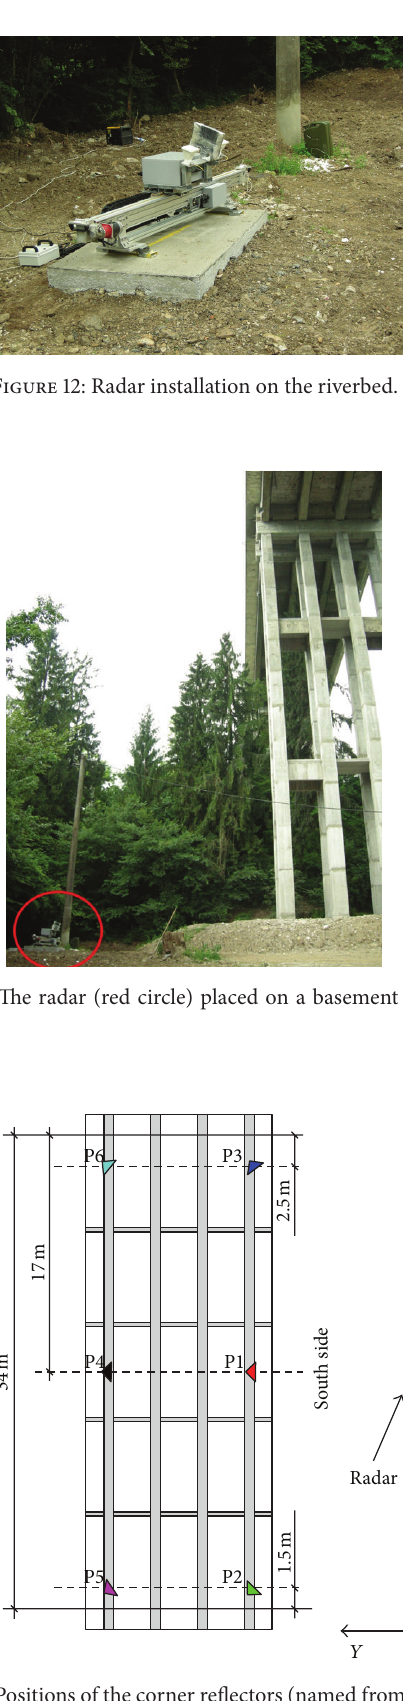
Figure 14: Positions of the corner reflectors (named from P1 to